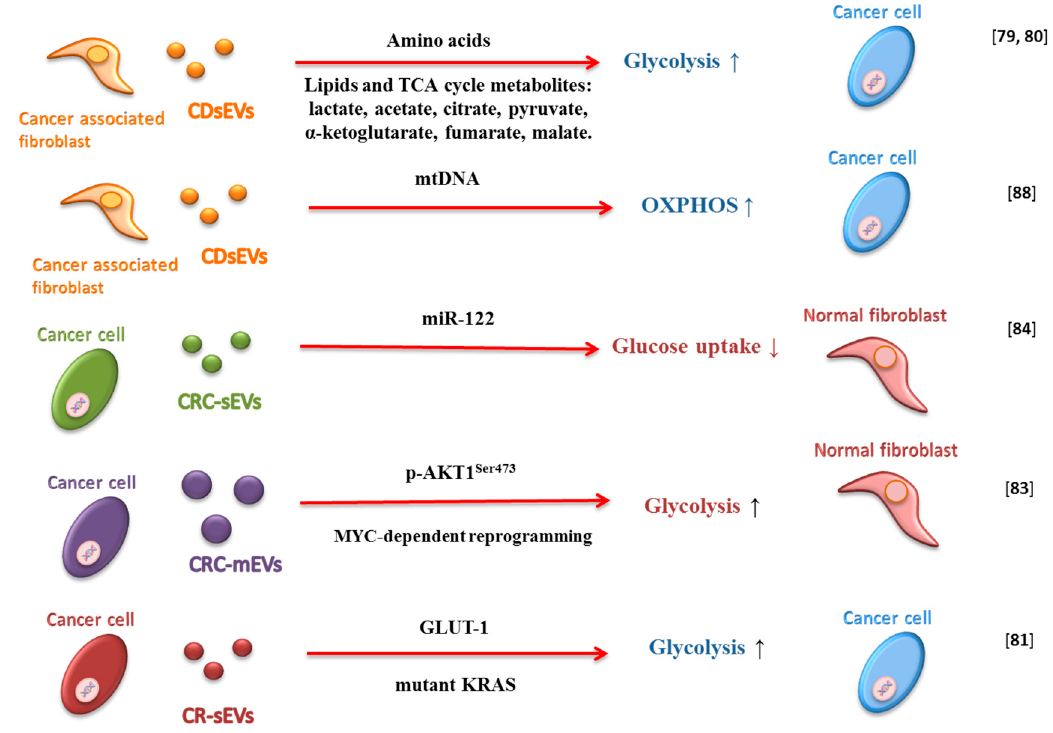
Figure 2. Schematic representation of how extracellular vesicles (Evs) influence metabolism in the tumor microenvironment. Small extracellular vesicles derived from cancer-associated fibroblast (CAF-EVs) can stimulate glycolysis and OXPHOS by metabolite cargo and mtDNA. Colorectal cancer-derived small extracellular vesicles (CRC-sEVS) can transport miRNA (i.e., miR-122) that can reduce glucose uptake in normal fibroblasts, and other proteins and enzymes that influence glycolysis in cancer cells. Finally, colorectal cancer-derived medium extracellular vesicles (CRC-mEVs) can increase glycolysis in normal fibroblasts.